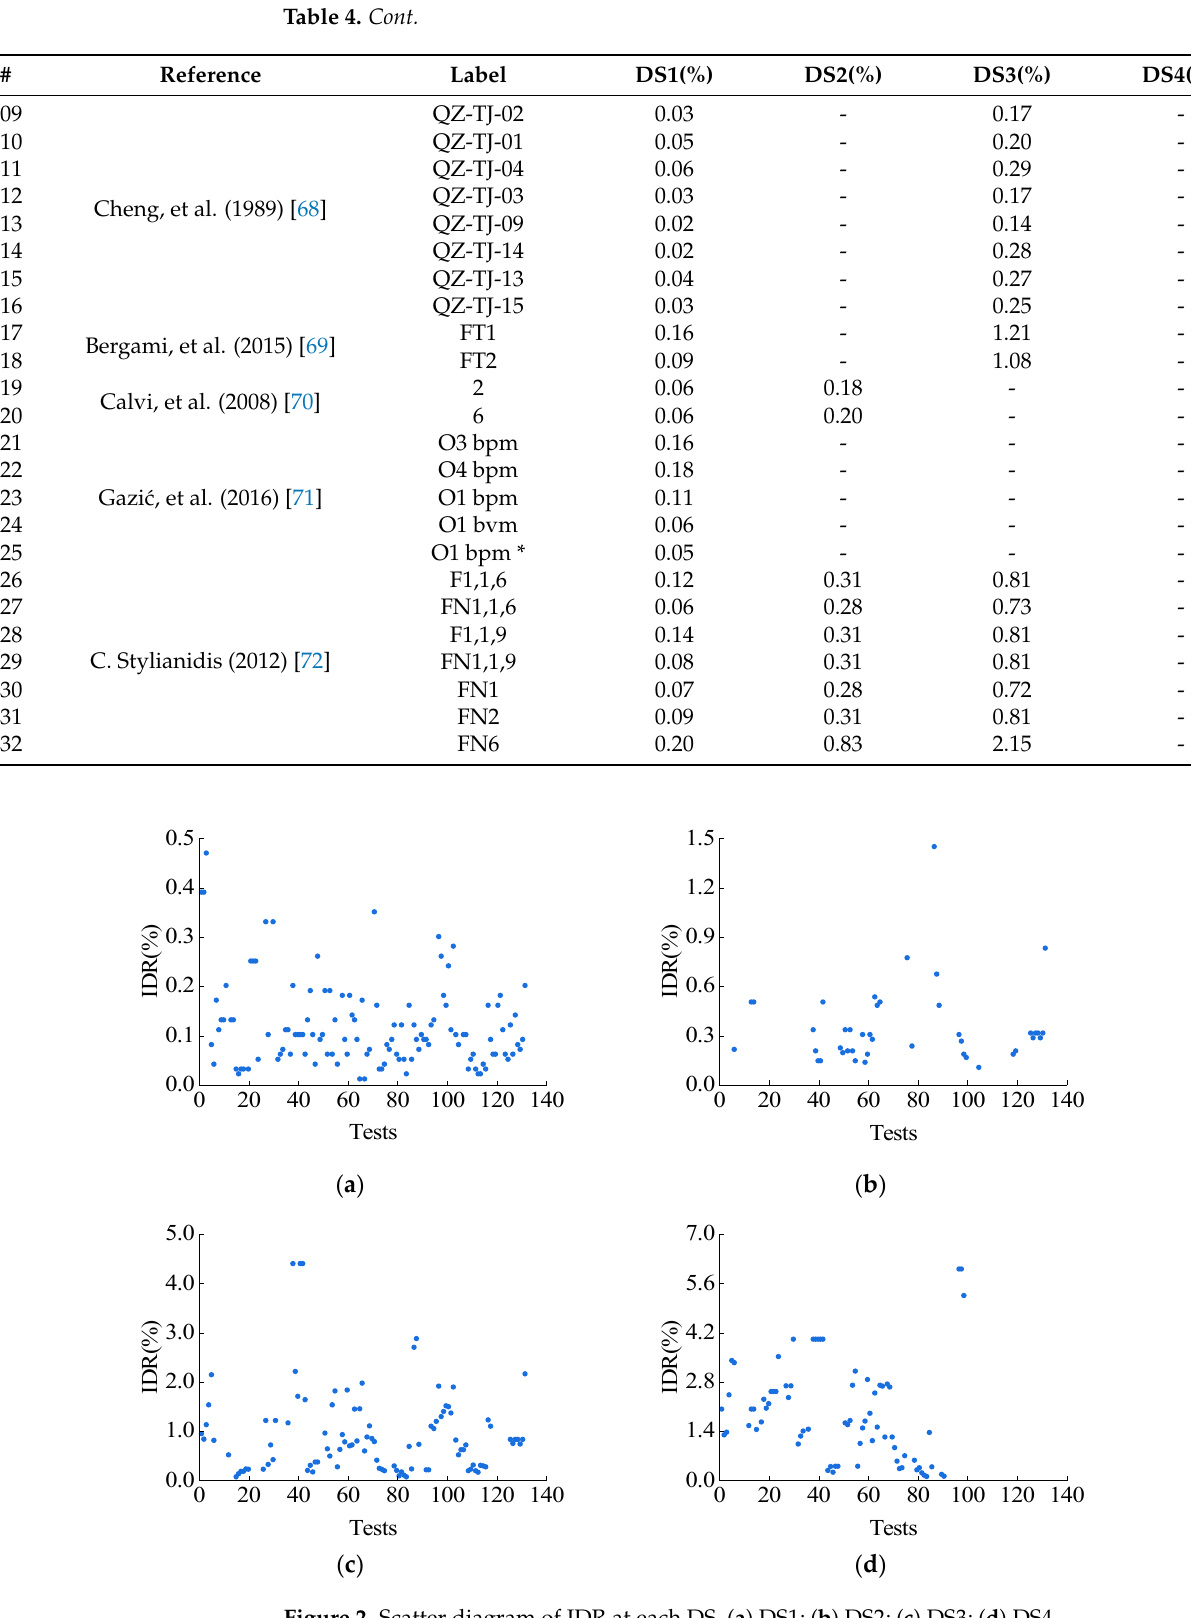
tion of the fragility function usually adopts a lognormal cumulative distribution function, as shown in Equation (1).